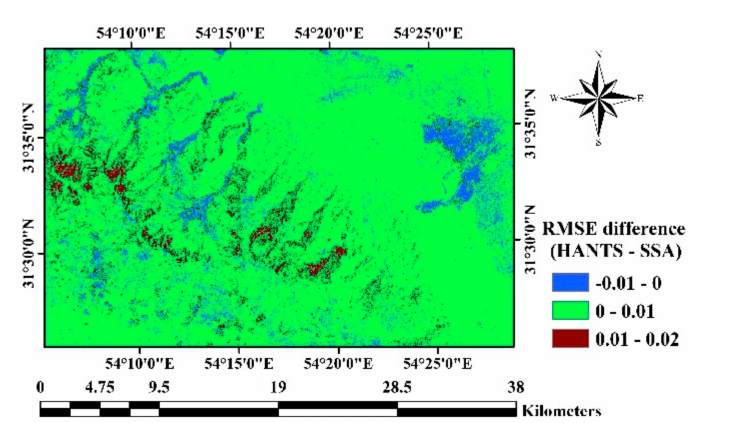
Figure 11. Di ff erence between RMSE map of HANTS and M-SSA. Positive values show that the RMSE in HANTS is higher than M-SSA and vis versa.